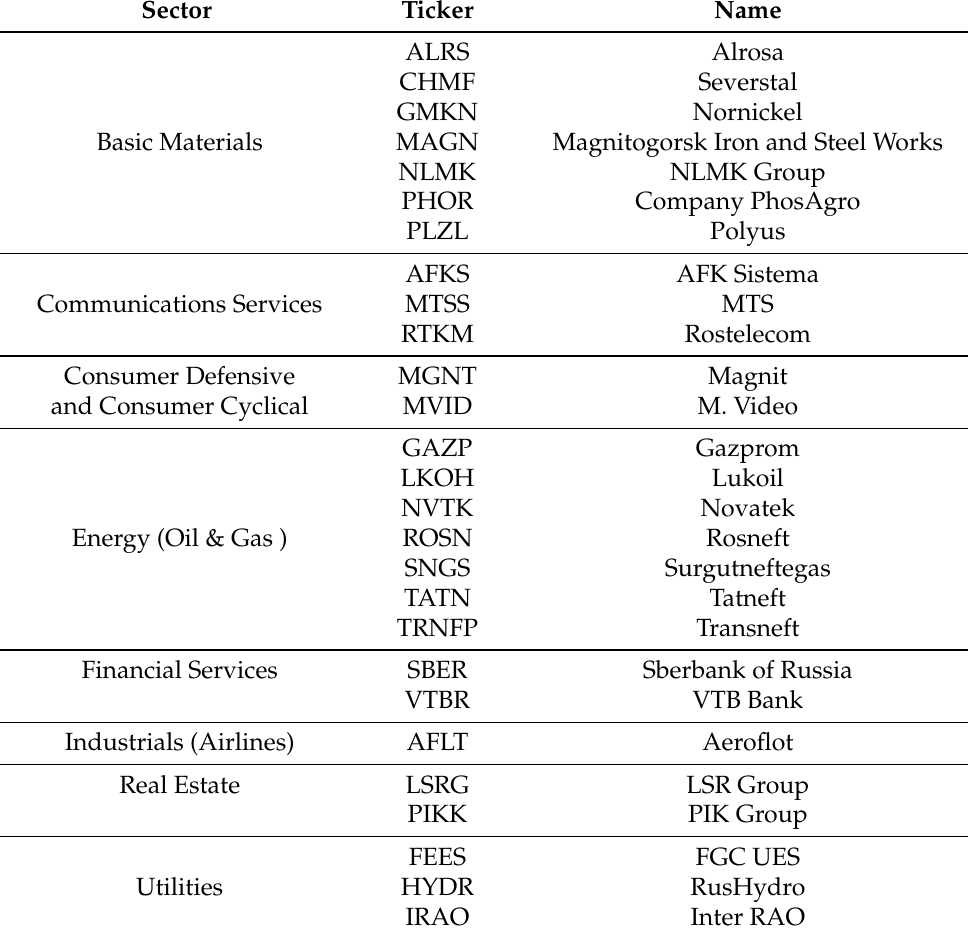
Table 1. Companies with tickers classified by